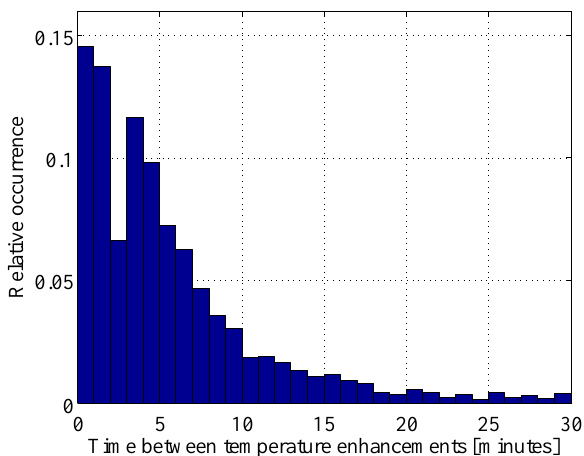
Fig. 6. Superposed epoch analysis of enhanced perpendicular tem- perature events. For each event the values have been normalized to the range 0 to 1 by dividing with the maximum value in the super- posed epoch window of ± 2min. The x-axis shows the time relative to the enhanced temperature events [minutes]. The y-axis shows the normalized value of the following parameters:Black: Density Blue: parallel velocity, Green: number flux, Red: perpendicular temperature, Cyan: magnitude of perpendicular velocity and Ma- genta: magnitude of vector change of perpendicular